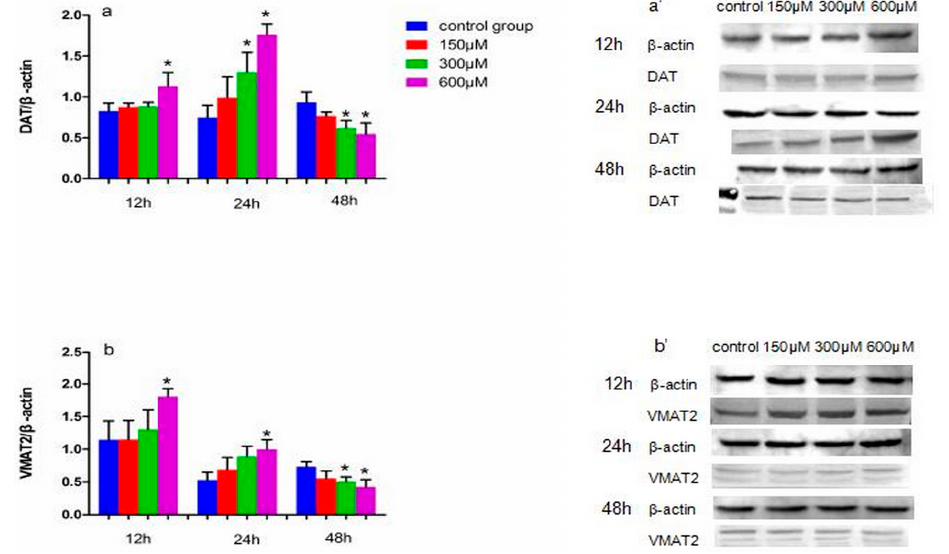
Figure 4. The effects of exposure to simazine for 12, 24, 48 h on expression of DAT ( a , a’ ), VMAT2 ( b , b’ ) protein in MN9D cells determined with a western blotting analysis. Bars indicate mean ± S.E.M. * statistically significant difference compared with the control, * p < 0.05, 3 repeated experiments for each group, n = 3.